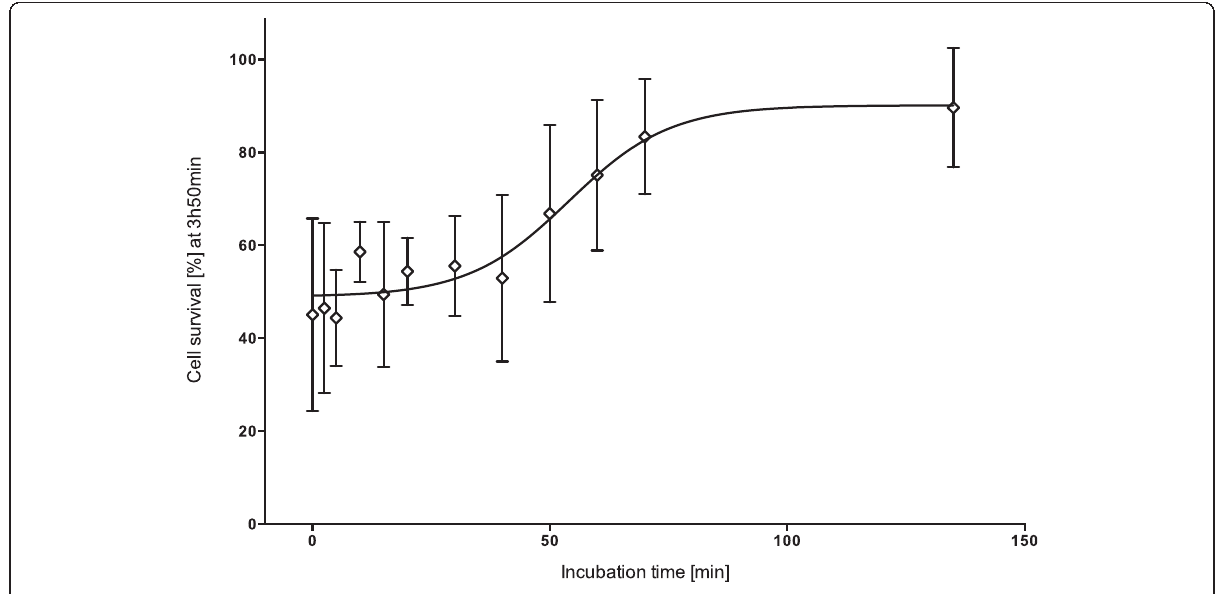
Figure 2 Effect of incubation time of C. fleckeri antivenom (156.41 units/mL) with venom (1.47 μ g/mL) on cell survival at three hours and 50 minutes after exposure to the cells. The error bars represent 95% CI for each mean (three